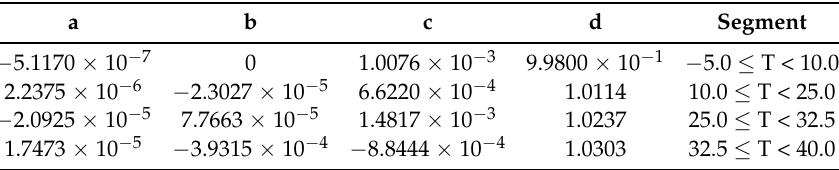
Table 4. Smoothing spline